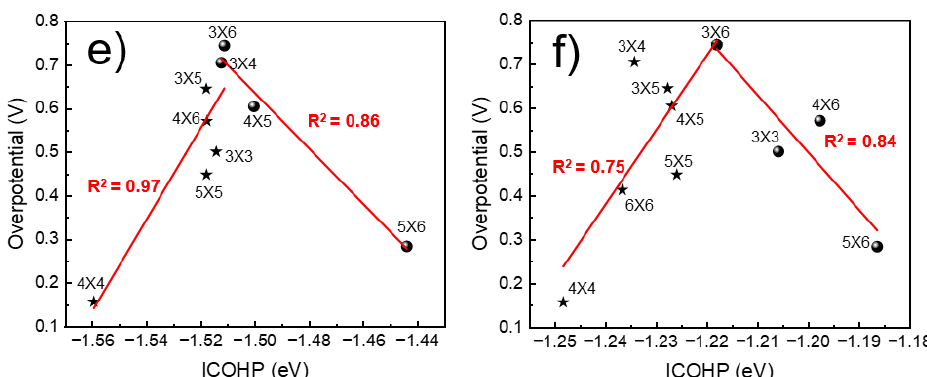
Figure 4. ( a – d ) The COHP distribution of In ‐ O bonds in different supercells of InN 4 , and from left to right are InN 4 ‐ 3 × 3, InN 4 ‐ 4 × 4, InN 4 ‐ 5 × 6, InN 4 ‐ 6 × 6; ( e ) The volcano ‐ like relationship between 2e − ORR overpotential and the integral of the Crystal Orbital Hamilton Population (ICOHP) between 5p orbital of In atom and s and p orbitals of O (OOH); ( f ) The volcano curve between 2e − ORR overpotential and the integral of the Crystal Orbital Hamilton Population (ICOHP) between the 5 p z orbital of In atom and the s and p orbitals of O (OOH).